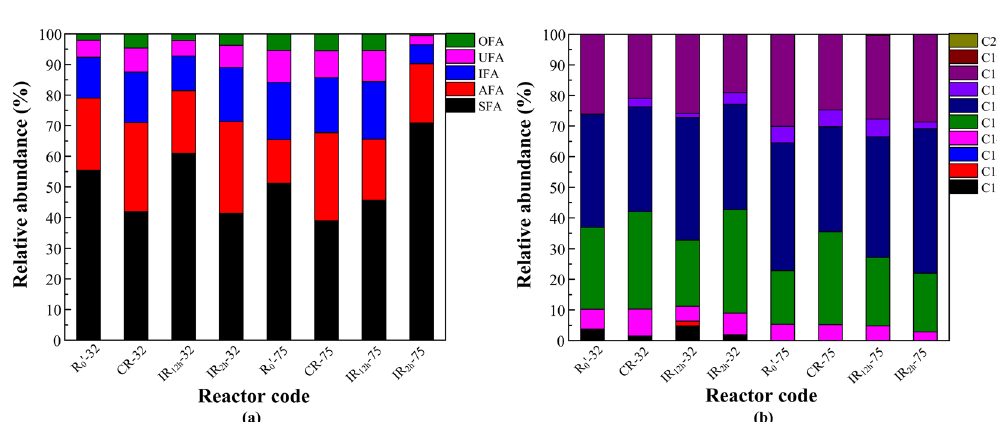
Figure 4. PLFA profiles of the activated sludge in four reactors on day 32 and day 75. ( a ) By structure; ( b ) By the number of carbon atoms. SFA = saturated fatty acids, AFA = anteiso-branched fatty acids, IFA = iso- branched fatty acids, UFA = unsaturated fatty acids, OFA = other fatty